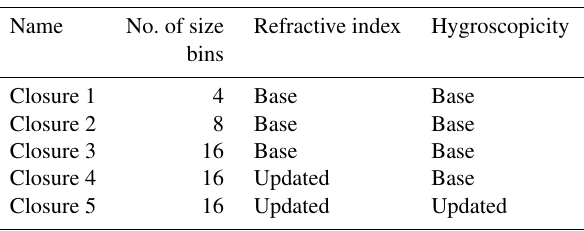
Table 4. Description of closure cases. Refer to Sect. 3.2 for defini- tions of the base and updated configurations. Size bins are defined in Table